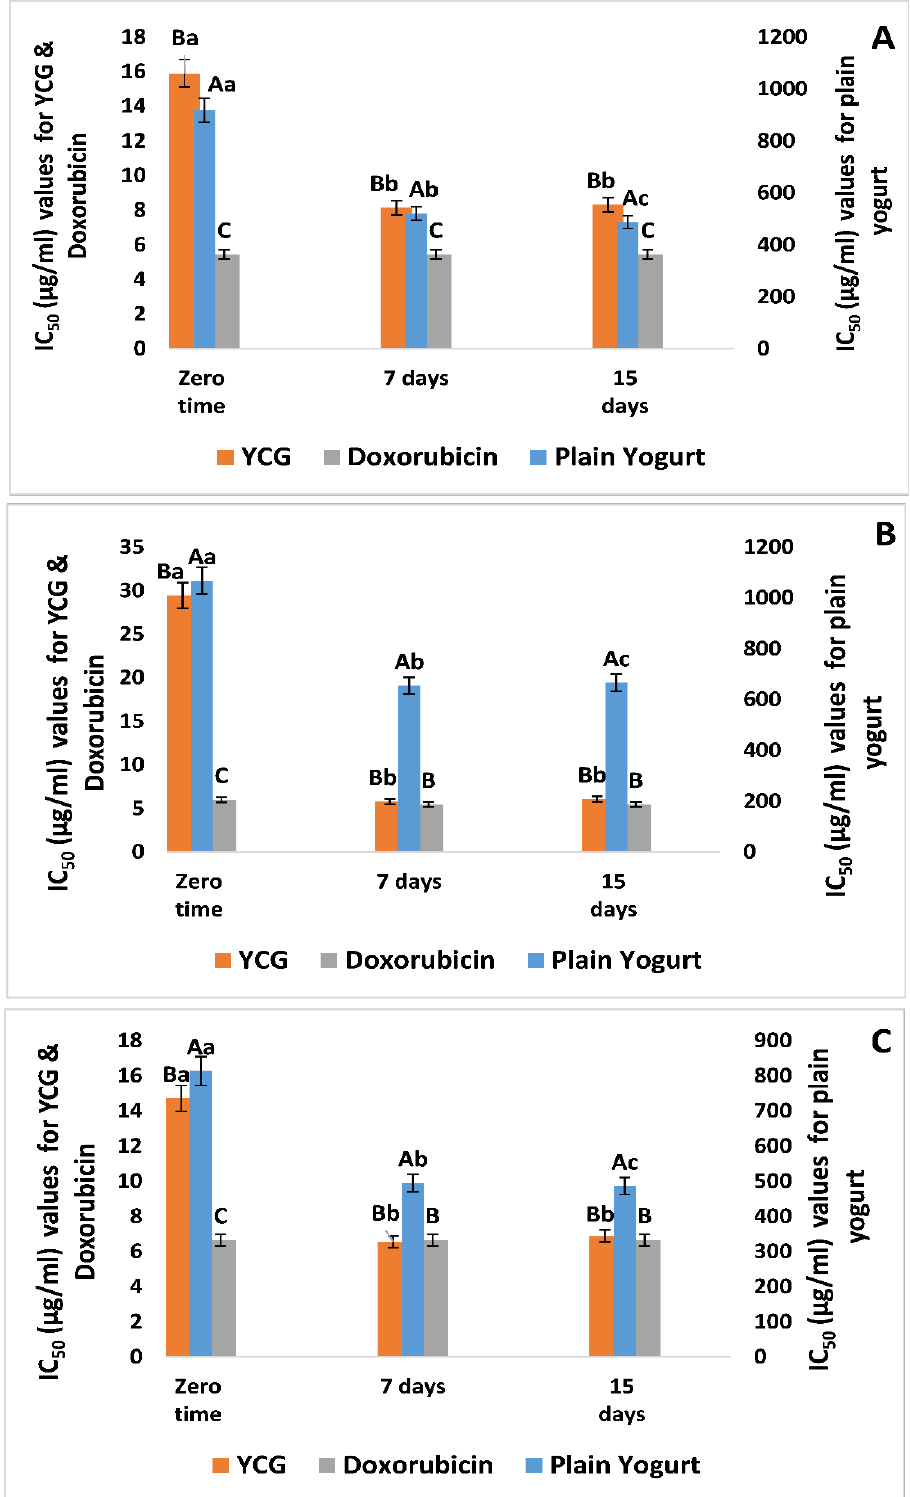
Figure 2. Comparison of the inhibition percentage between different types of postbiotics with dif- ferent concentrations against tumor cells. Where ( A , D ), ( B , E ) and ( C , F ) for breast (MDA-MB231), colon (LS-174T), and prostate (PC-3) cell lines, respectively. Besides, ( G ) for positive control (Doxo- rubicin). Different uppercase superscripts point out significant ( p < 0.05) differences between the values for different concentrations. Different lowercase superscripts point out significant ( p < 0.05) differences between the values during the storage period. Vertical bars present the standard division of the treatment means.